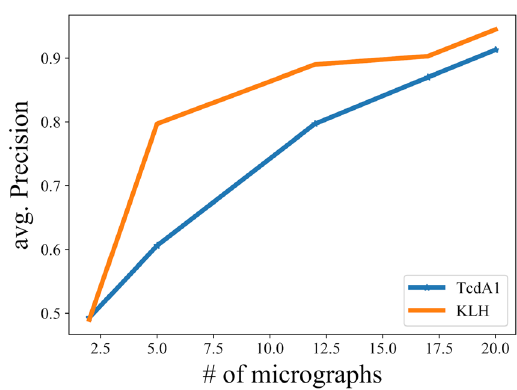
Fig. 8 Effect of the number of micrographs used for training. Graph showing the average precision values for coordinates of TcdA1 and KLH which are predicted by models trained using different numbers of micrographs. It is to be noted that the number varies for different datasets. Training with at least 12 micrographs was required for KLH, whereas training with 20 micrographs was required for TcdA1 to get a prediction AUC score above 0.9.